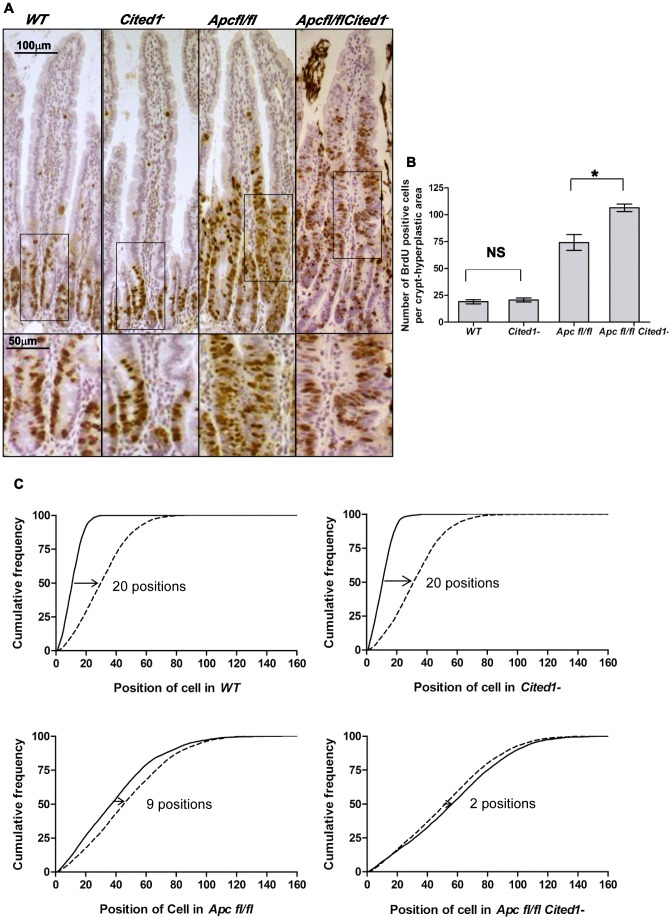

Cited1 deficiency increases enterocyte proliferation and decreased cell migration in AhCre+Apcfl/fl mice.
A:
 Cell proliferation assessed by IHC (immunohistochemistry) in AhCre+WT (WT), AhCre+Cited1−, (Cited1−) AhCre+Apcfl/fl(Apcfl/fl) and AhCre+Apcfl/flCited1−(Apcfl/flCited1−) mice. Bottom panels show magnifications of intestine of corresponding zone. B: Histograms showing the number of BrdU positive cells/crypt or hyperplastic areas. No significant difference in the localisation or number of BrdU positive cells between AhCre+WT and AhCre+Cited1
− (p = 0.6625). Significant increase in the number of BrdU positive cell in AhCre+Apcfl/flCited1− compared to AhCre+Apcfl/fl (*p = 0.0404). C: Graphs showing the position of BrdU positive cells after 2 hrs (solid line) and 24 hrs (dashed line). The cumulative frequency represents the percentage of BrdU positive cells at a particular position from the bottom of the crypt or hyperplastic areas to the tip of the villus. The difference between the 2 hrs and 24 hrs distributions for a genotype was analysed with the Kolmogorov–Smirnov test. The distribution of Brdu positive cells from 2 hrs to 24 hrs varies significantly for all genotypes (p = 0.01) indicating cell migration. The migration of cells from 2 hrs to 24 hrs after Brdu labelling is similar in AhCre+WT compared to AhCre+Cited1− as shown by the distance between the 2 distributions (20 cell positions at the 50% cumulative frequency). In AhCre+Apcfl/fl, the distance is reduced to 9 cell positions indicating reduced migration compared to AhCre+WT (20 positions) and AhCre+Cited1− (20 positions). The migration is further reduced in AhCre+Apcfl/flCited1− as the 50% cumulative frequency position moved only 2 positions, compared to AhCre+Apcfl/fl (9 positions). *p<0.05; Statistical tests were done using Mann-Whitney U test (B) or Kolmogorov–Smirnov test (C); NS Non significant. (N = 3/genotype).